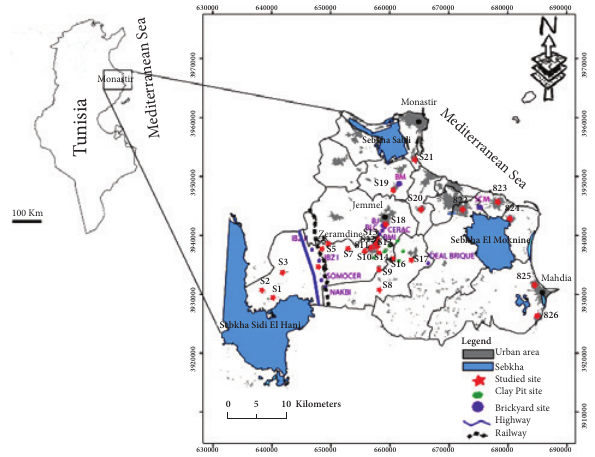
Figure 1. Map of the study area and sampling location in Monastir region,